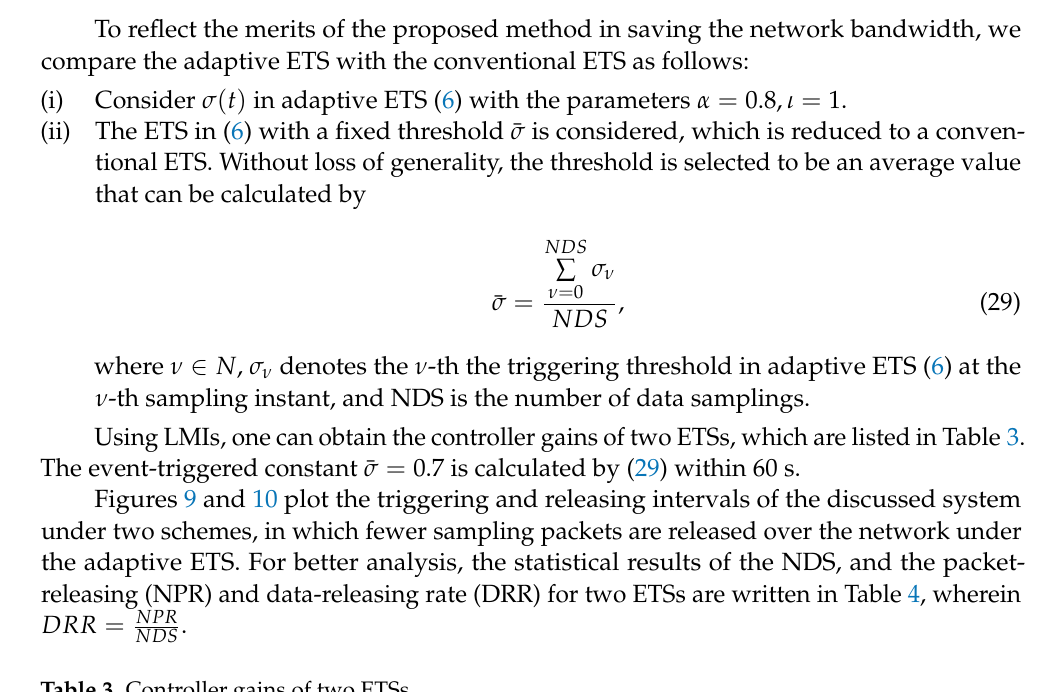
Table 3. Controller gains of two